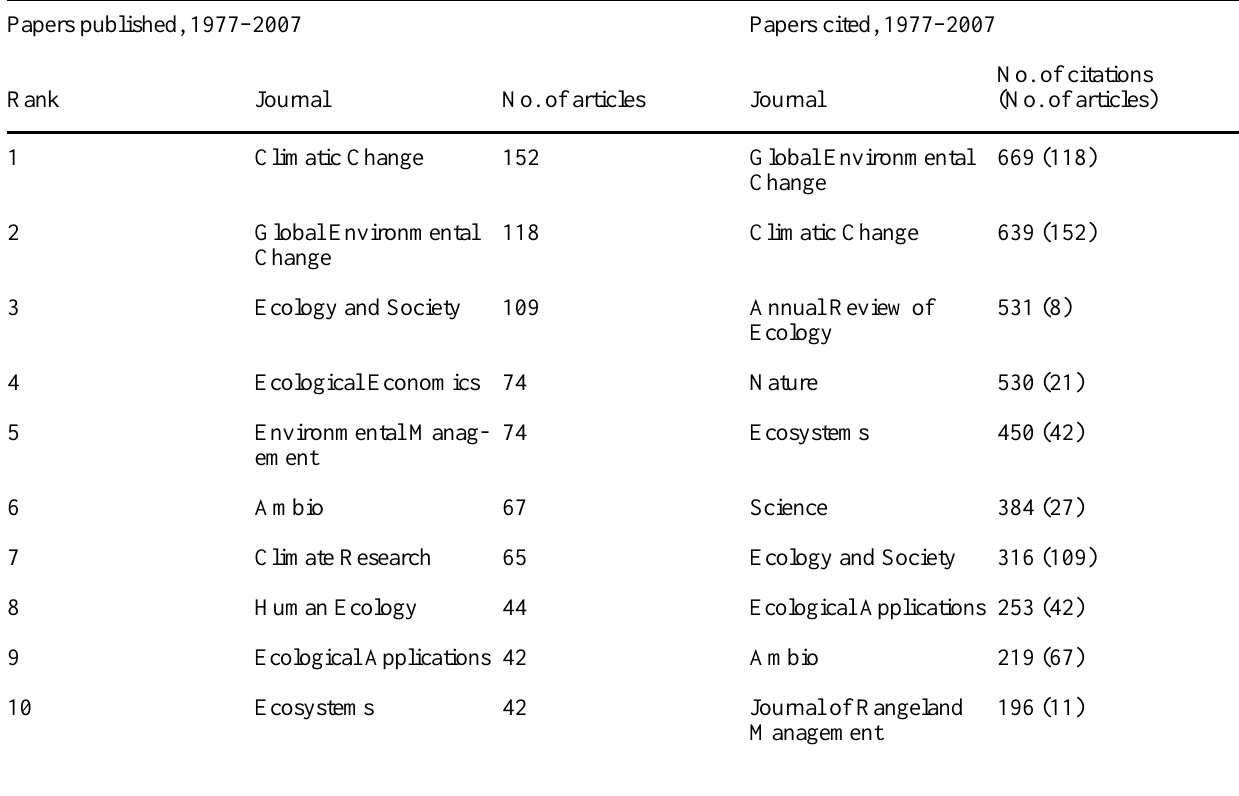
Table 1. The top ten journals with the greatest number of papers (left) and the greatest number of citations (right) within the whole database over the period